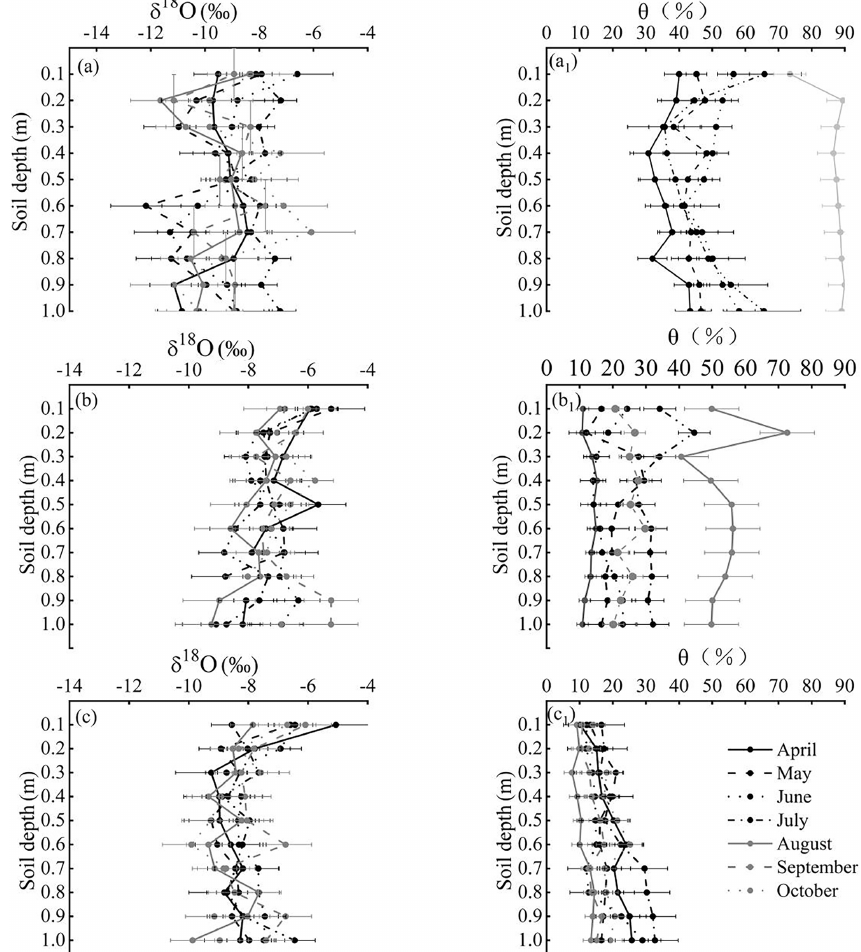
Figure 5. The variation in δ 18 O and soil water content ( θ , %) with soil depth. Panels (a–c) represent alpine meadow, forests and arid foothills,